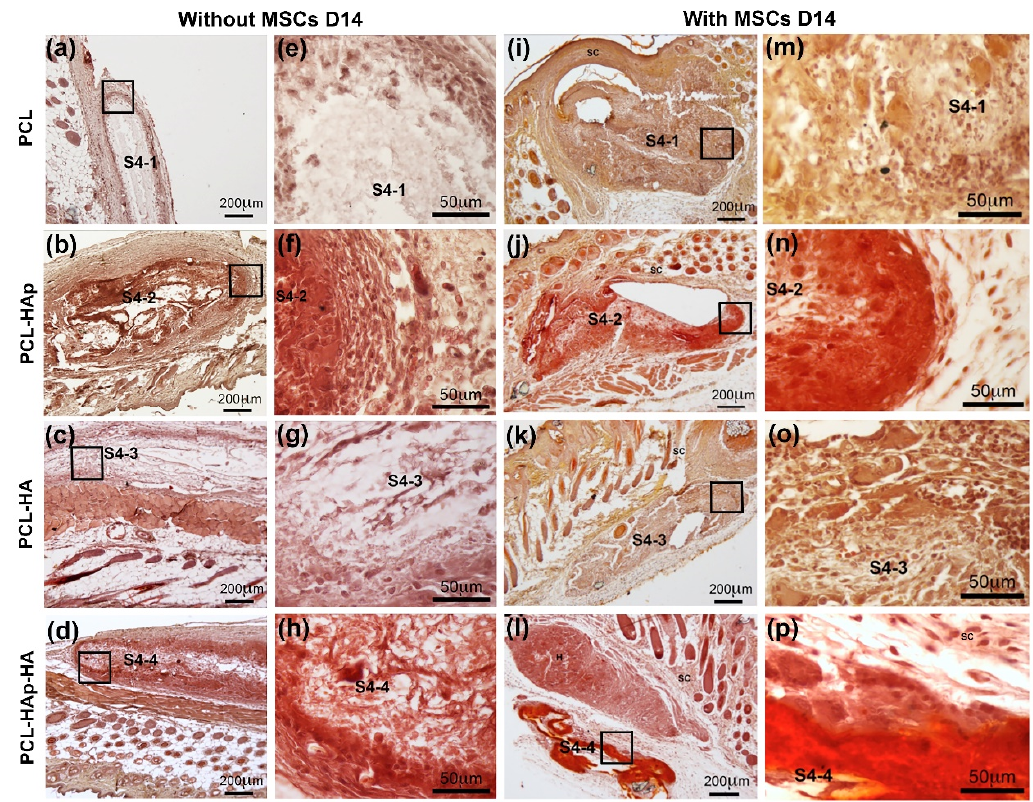
Figure 7. Histological staining with Alizarin Red S for PCL, PCL-HAp, PCL-HA, and PCL-HAp-HA scaffolds subcutaneously implanted without cells in ICR mice ( a – h ) and with hBM-MSCs in nude mice ( i – p ) for 2 weeks. ( a , e , i , m ) S4-1 for the PCL scaffold; ( b , f , j , n) S4-2 for the PCL-HAp scaffold; ( c , g , k , o ) S4-3 for the PCL-HA scaffold; and ( d , h , l , p ) S4-4 for the PCL-HAp-HA scaffold. Black squares indicate the enlarged areas.